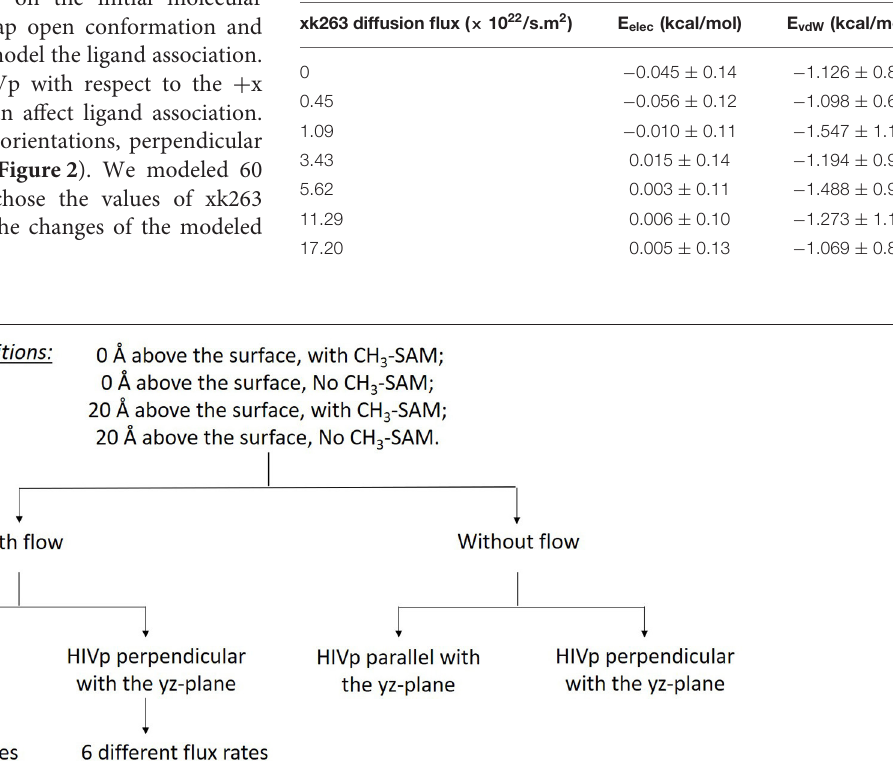
Frontiers in Molecular Biosciences |